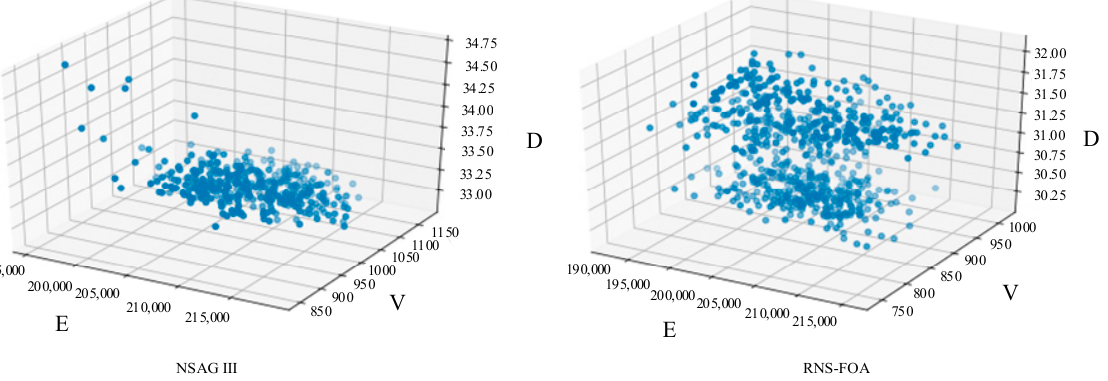
Figure 10. The population individual of the optimal solution set of the cell integration layout example.